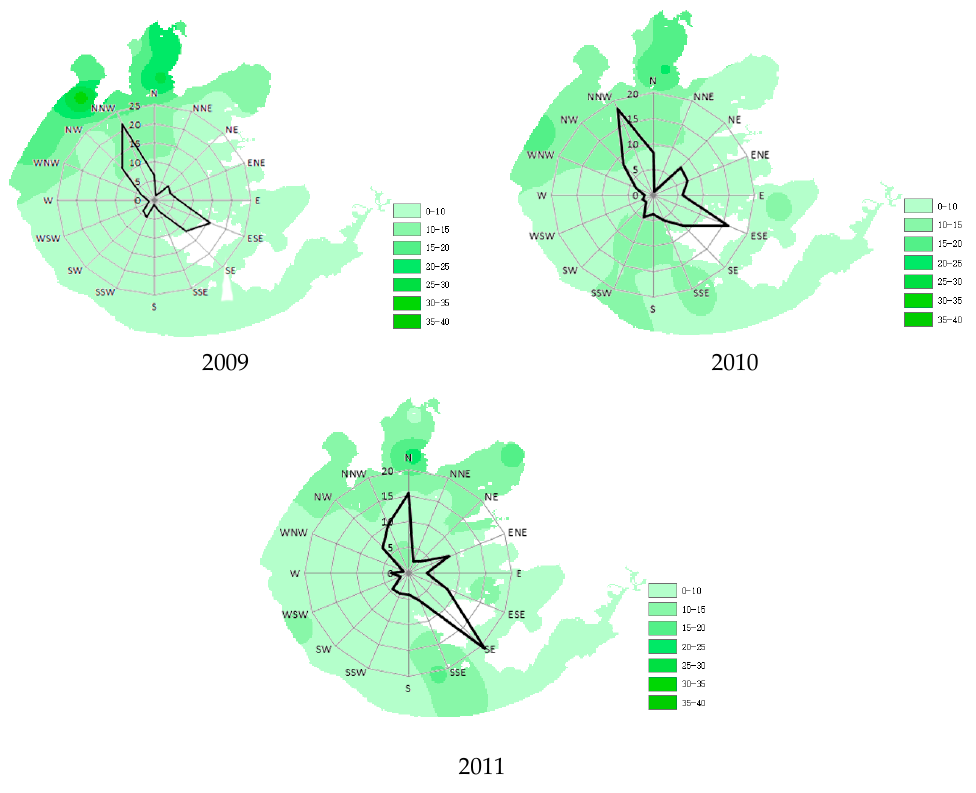
Figure 6. Map showing the spatial distribution of mean annual chlorophyll-a (Chl-a) concentration (µg·L − 1 ), superimposed by the plot (signified by black line) of wind direction occurrence.